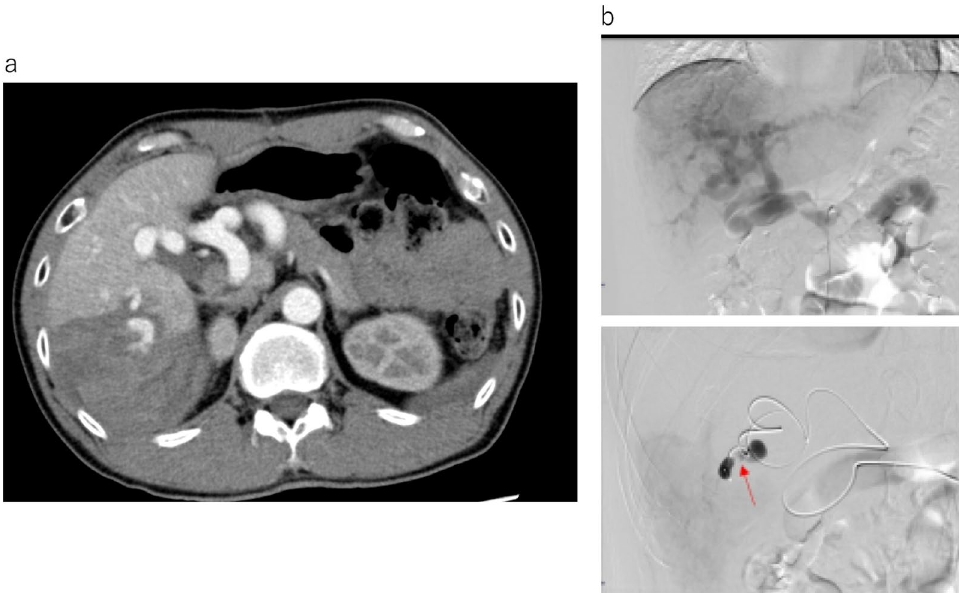
Fig. 3 CT and interventional radiology (IVR) at abdominal hemorrhage. Enhanced-computed tomography (CT) shows poor liver regeneration of the right lobe, exposed blood vessels on the resected surface of the liver, and contrast medium leaking from the blood vessels on the resected surface of the liver into the abdominal cavity ( a ). An angiographic image approaching from the right external iliac artery ( b ). The bleeding site could not be identified by contrast imaging from the celiac artery root, because the hepatic artery was dilated and the flow velocity was fast (upper panel). When A6 was selected, the site of contrast medium leakage was confirmed (lower